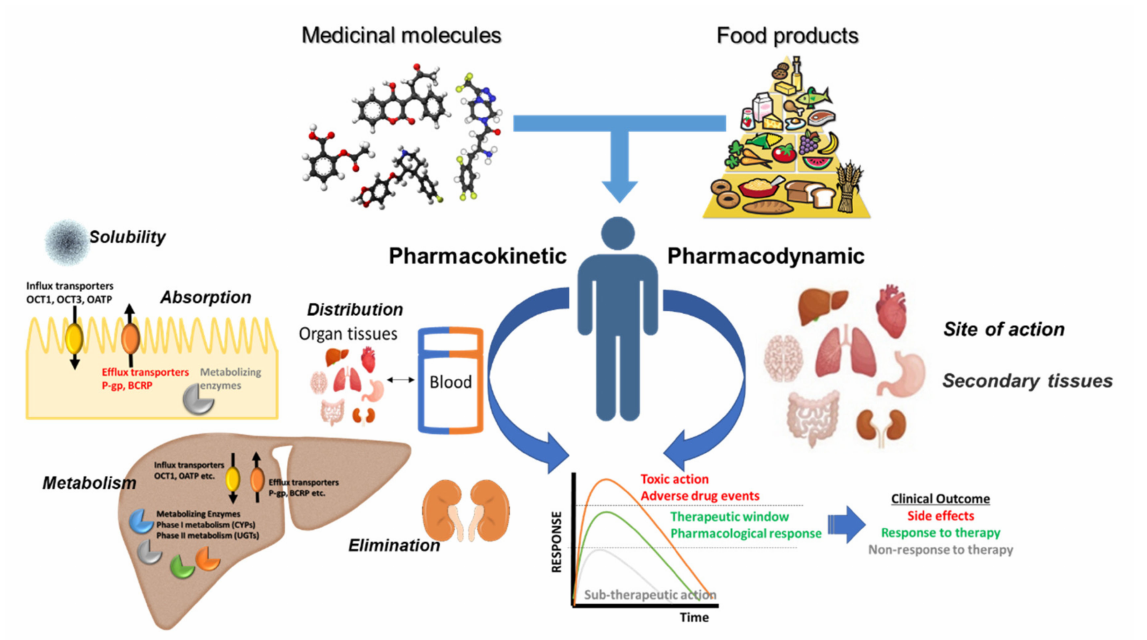
Figure 1. Representation of pharmacological mechanisms of DFIs and their impact on clinical outcome.